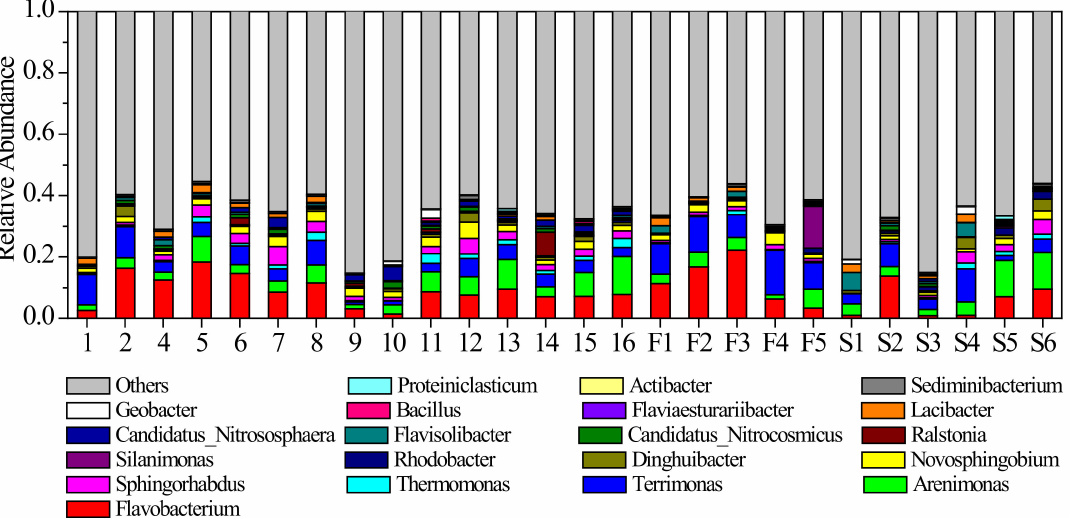
Figure 7. Average abundance proportions of dominant sediment microbial genera at different sites in the river. Values are expressed as the mean of each measurement.